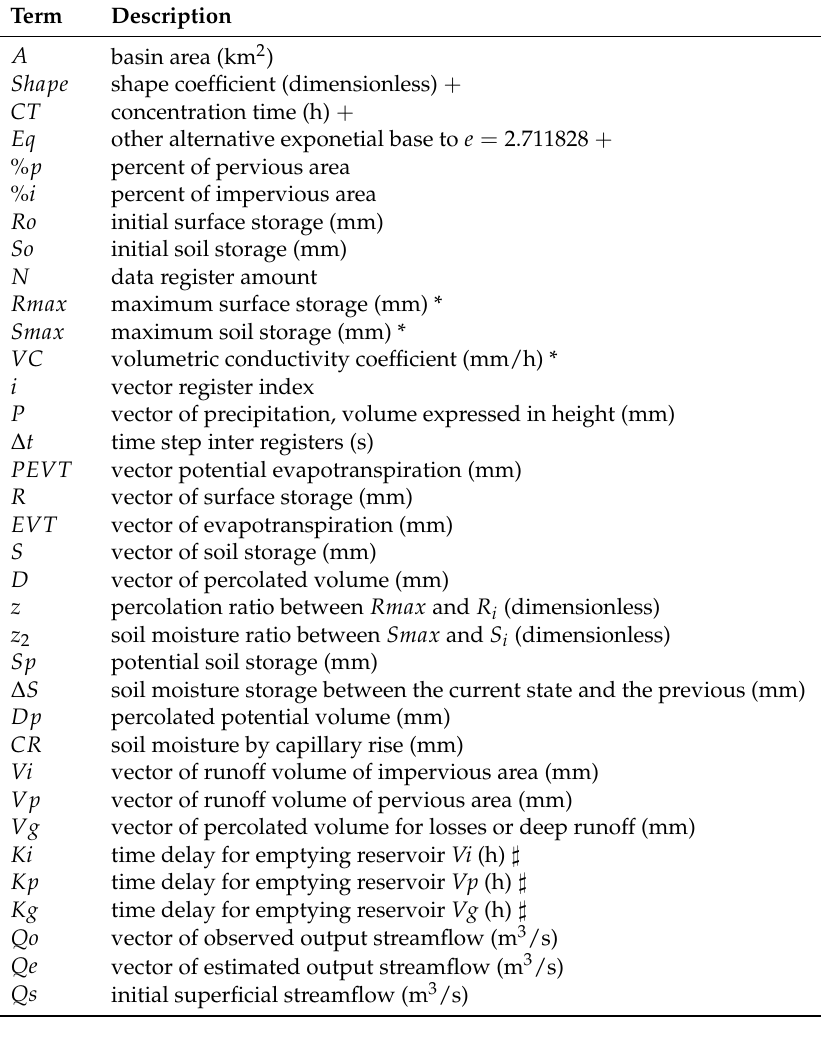
Table 1. Description of the terms in flowchart of Figure 2 and in